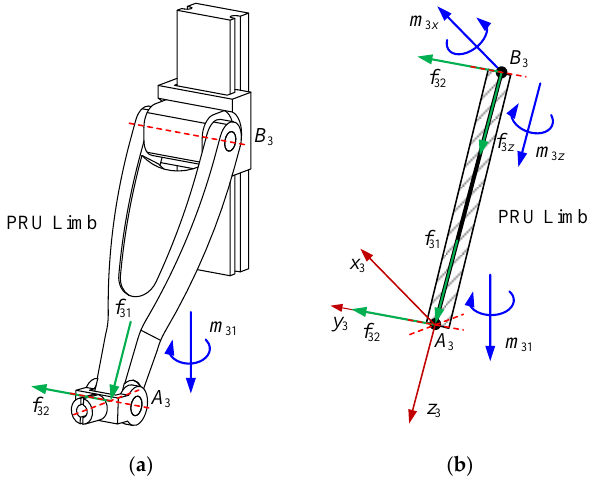
Figure 4. Distributions of wrenches exerted on the PRU limbs: ( a ) wrenches in the PRU limb; ( b ) projections of the wrenches in the PRU limb. The decomposed results of three wrenches along the axes of the limb coordinate frame